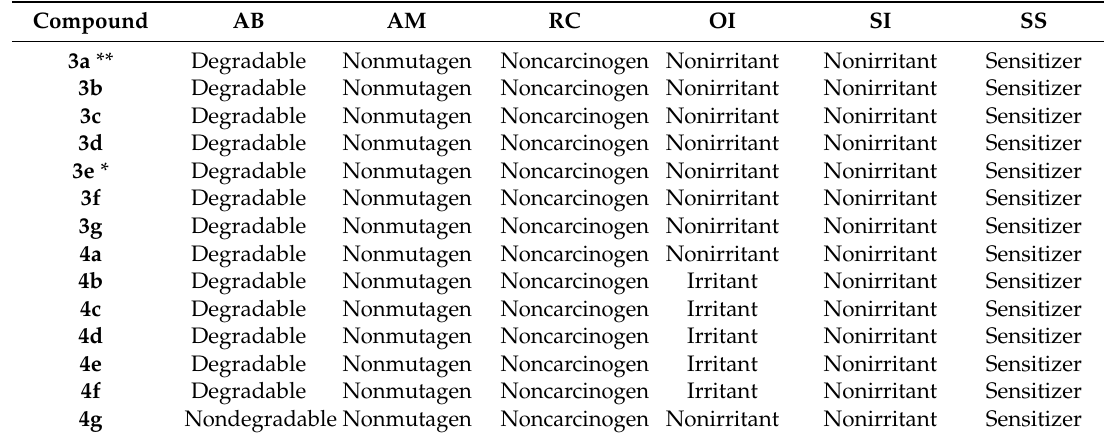
Table 5. Results of toxicity predictive test on six important